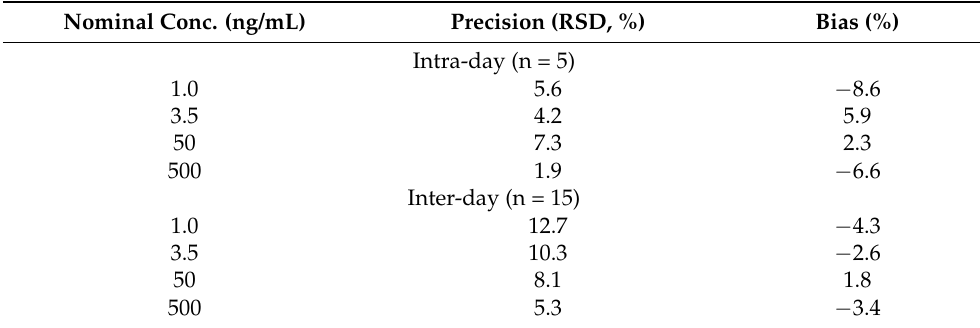
Table 2. Intra- and inter-day precision and bias of 5-AIQ in plasma at LLOQ, LQC, MQC and HQC concentration).